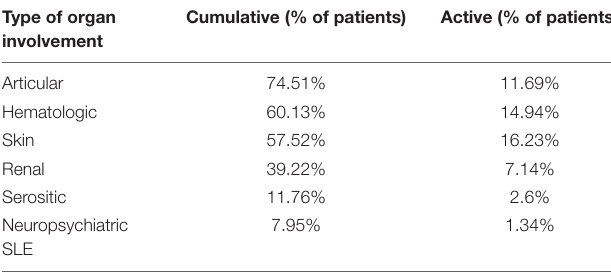
TABLE 1 | Cumulative and active organ involvement of enrolled patients.